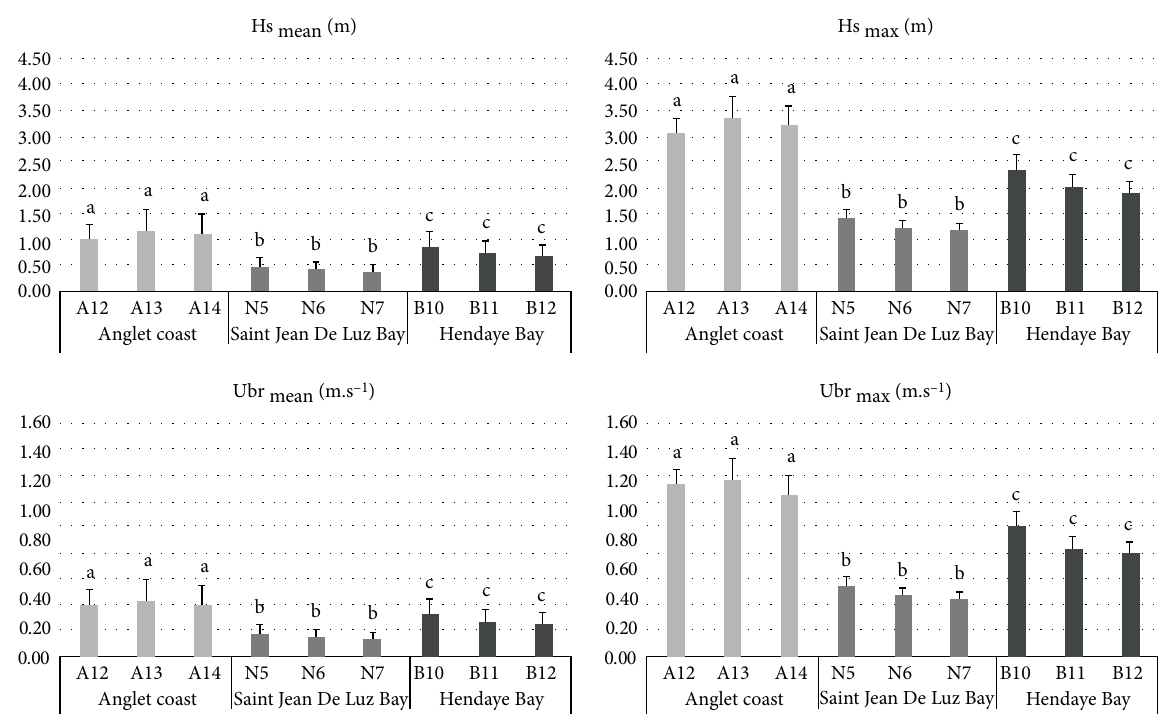
Figure 2: Four wave variables in the three exposed sites. The error bars represent the standard deviation for each station during the eight sampling campaigns. Different letters indicate statistically significant differences ( 푃 < 0.01